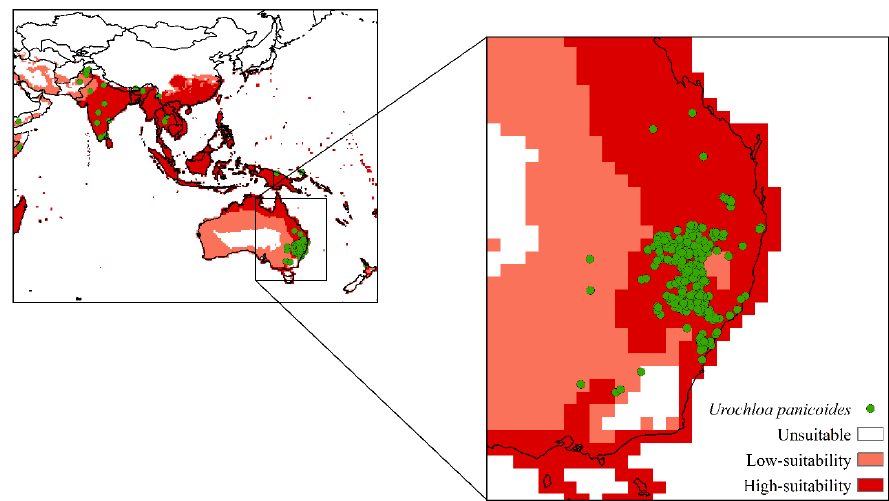
Figure 3. Current distribution of Urochloa panicoides in a validation region based on the Ecoclimatic Index (EI). Unsuitable areas in white (EI = 0), low-suitability areas in light red (0 < EI < 30), and high-suitability areas in red (30 < EI < 100).